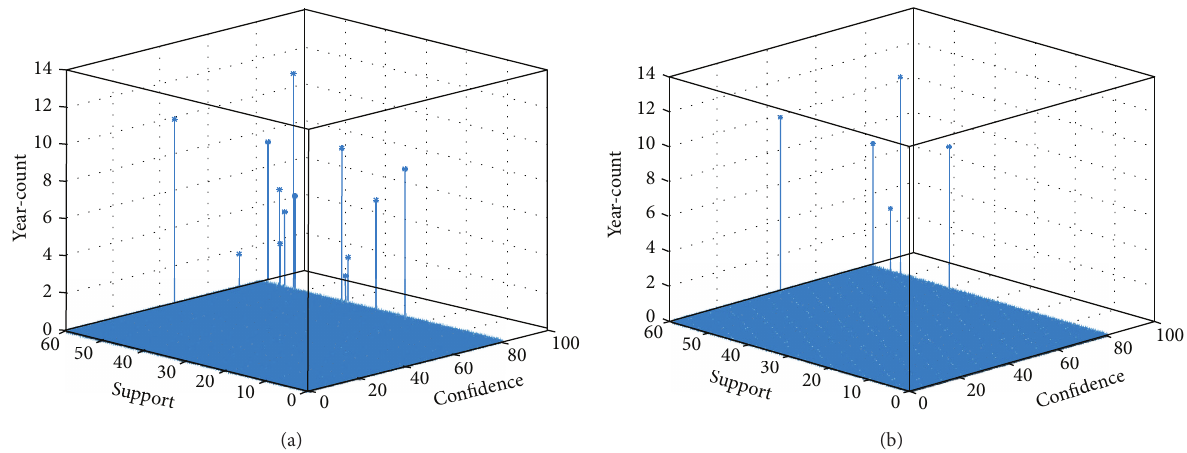
Figure 9: Histogram of the confidence and support measures as bins of year-count before (a) and after (b) thresholding for PredSet1.